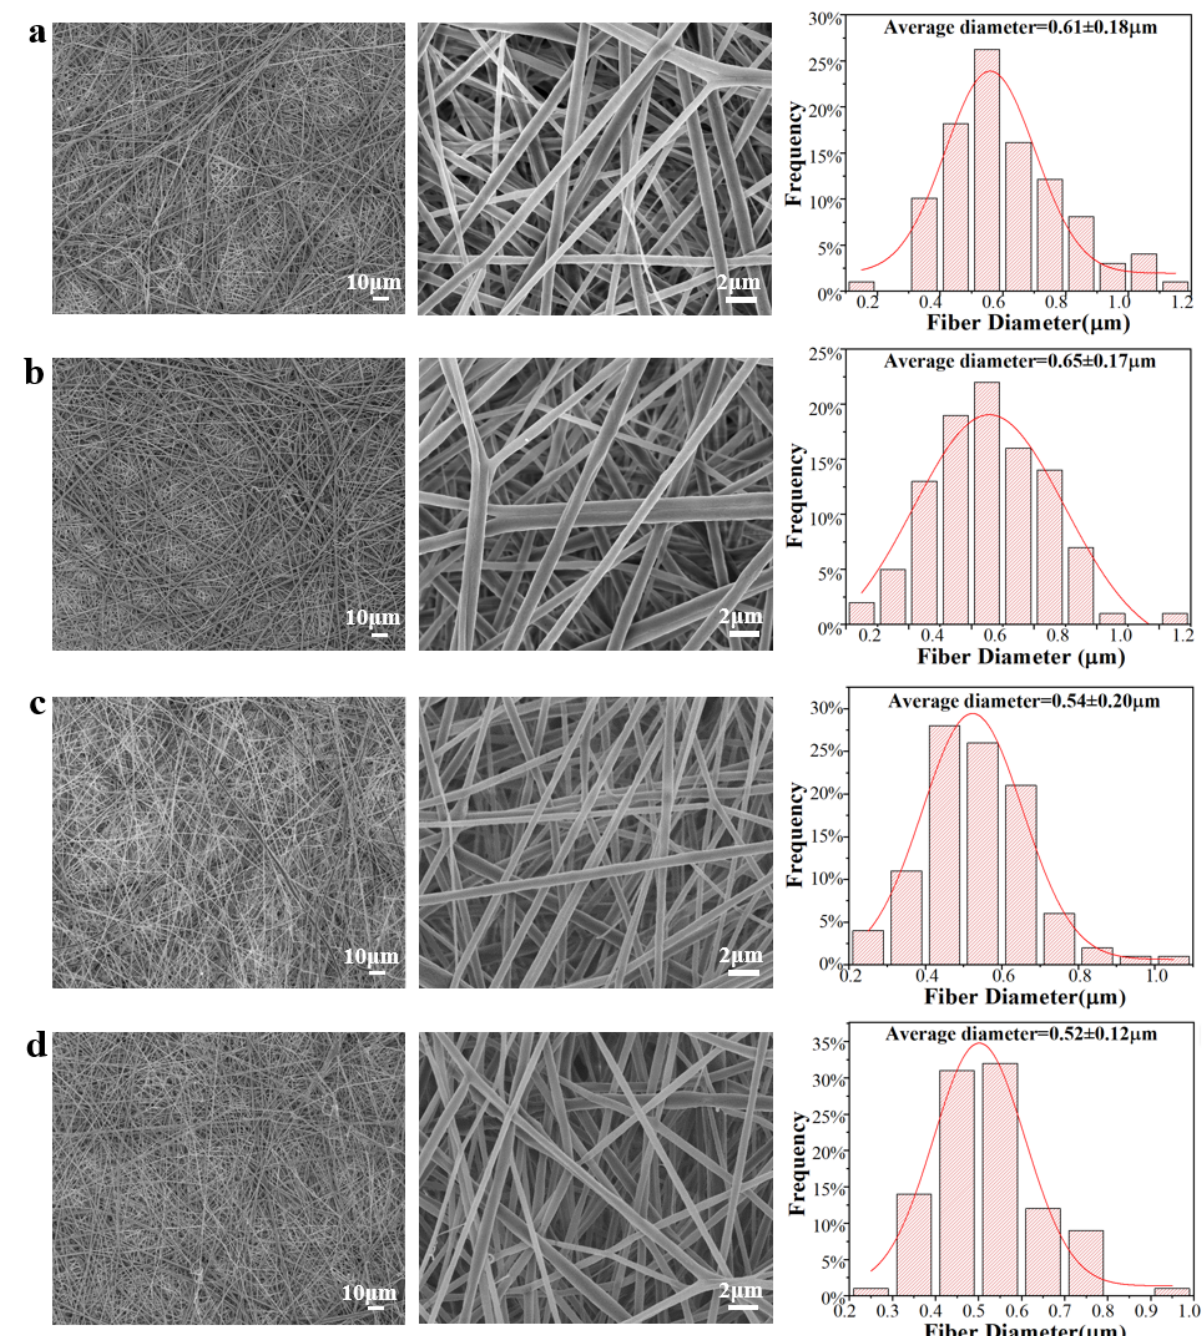
Figure 1. SEM images at different magnifications (500 × , 5000 × ) and diameter distribution of electro- spun membranes: ( a ) PLA; ( b ) PLA/rhPTH(1-34); ( c ) PLA/GO; ( d ) PLA/GO/rhPTH(1-34). The elongation percentages of different composite membranes are shown in Figure